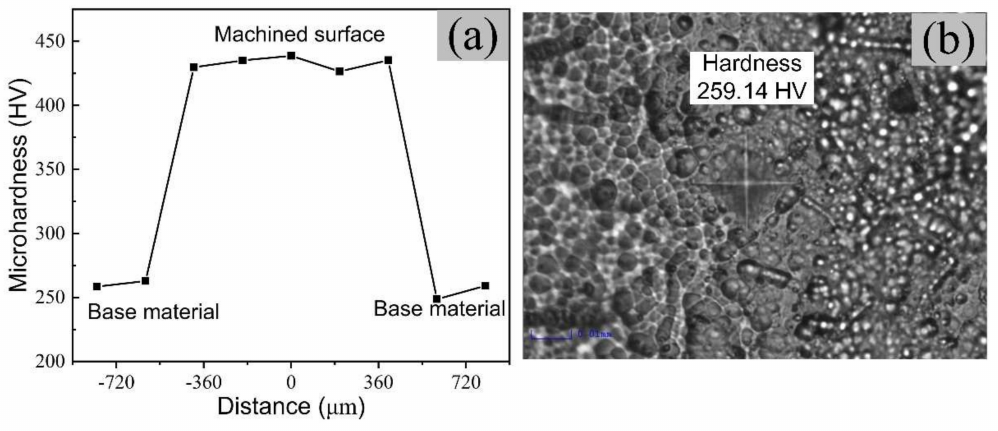
Figure 14. Measurement of surface microhardness of TiNi SMA: ( a ) microhardness curve of the surface and ( b ) microhardness measurement of the substrate